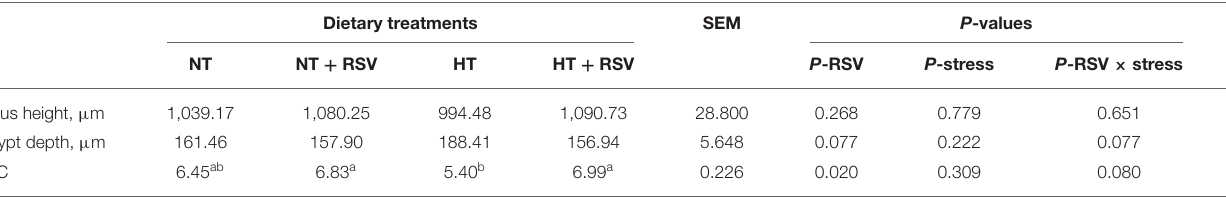
TABLE 5 | Effect of heat stress and RSV on the morphology of jejunum of 42-day-old broilers (d 14 of heat treatment). Dietary treatments SEM P -values NT NT + RSV HT HT + RSV P -RSV P -stress